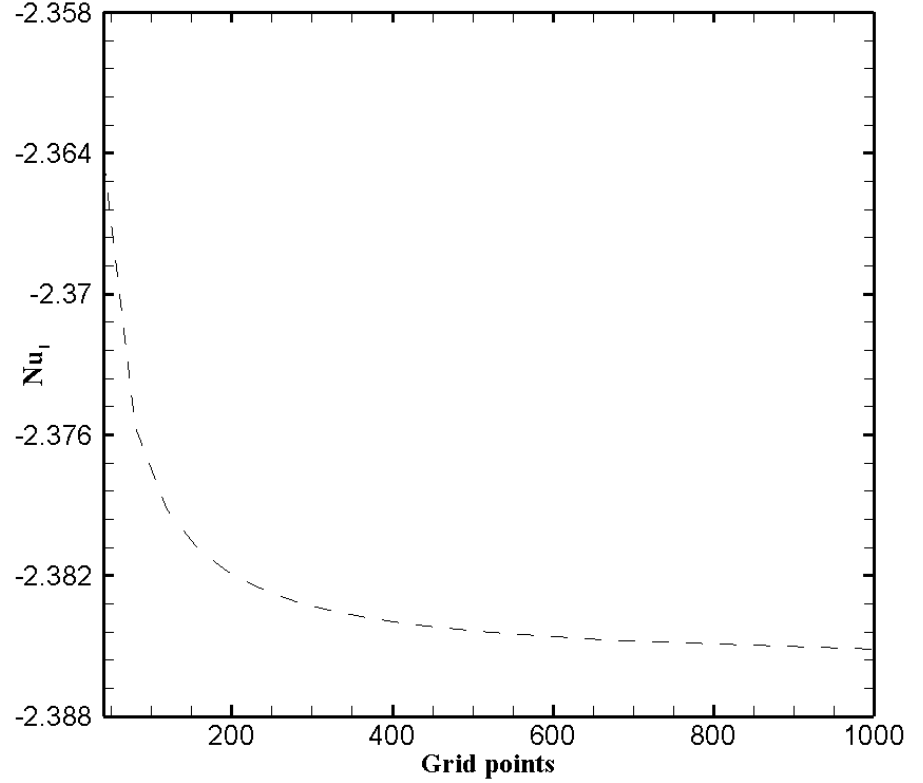
Figure 2. Grid independence